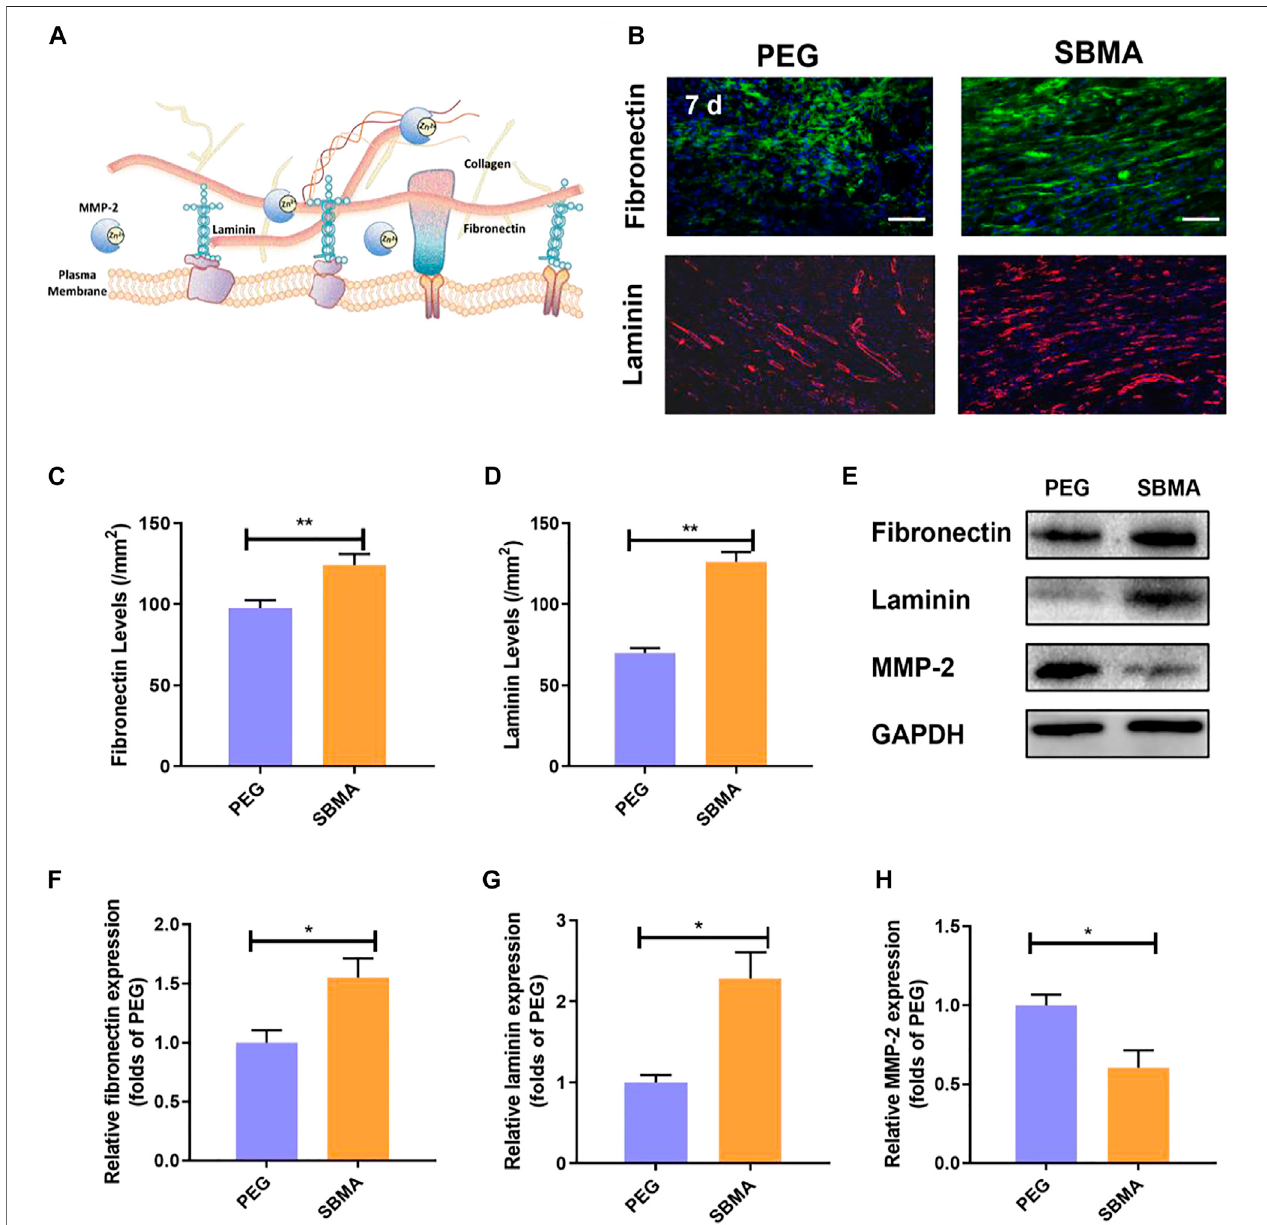
FIGURE 5 | In vivo ECM production. (A) Scheme of ECM production. (B) Immuno fl uorescent staining of fi bronectin (green) and laminin (red) for the two groups on day7(scalebar (cid:1) 50 µm). (C) Quantitative fi bronectinlevelsinwoundsonday7forthetwogroups. (D) Quantitativelamininlevelsinwoundsonday7forthetwogroups. (E) Western blotting for fi bronectin, and MMP-2 expressions in pressure ulcer of the PEG and SBMA groups. The gels have been run under the same experimental conditions,and cropped blotsareused here. (F – H) Opticaldensity valuesof fi bronectin,laminin,and MMP-2werequanti fi edand analyzed eachgroup. Signi fi cant difference is indicated as * p < 0.05, ** p < 0.01, *** p < 0.001, and n (cid:1)